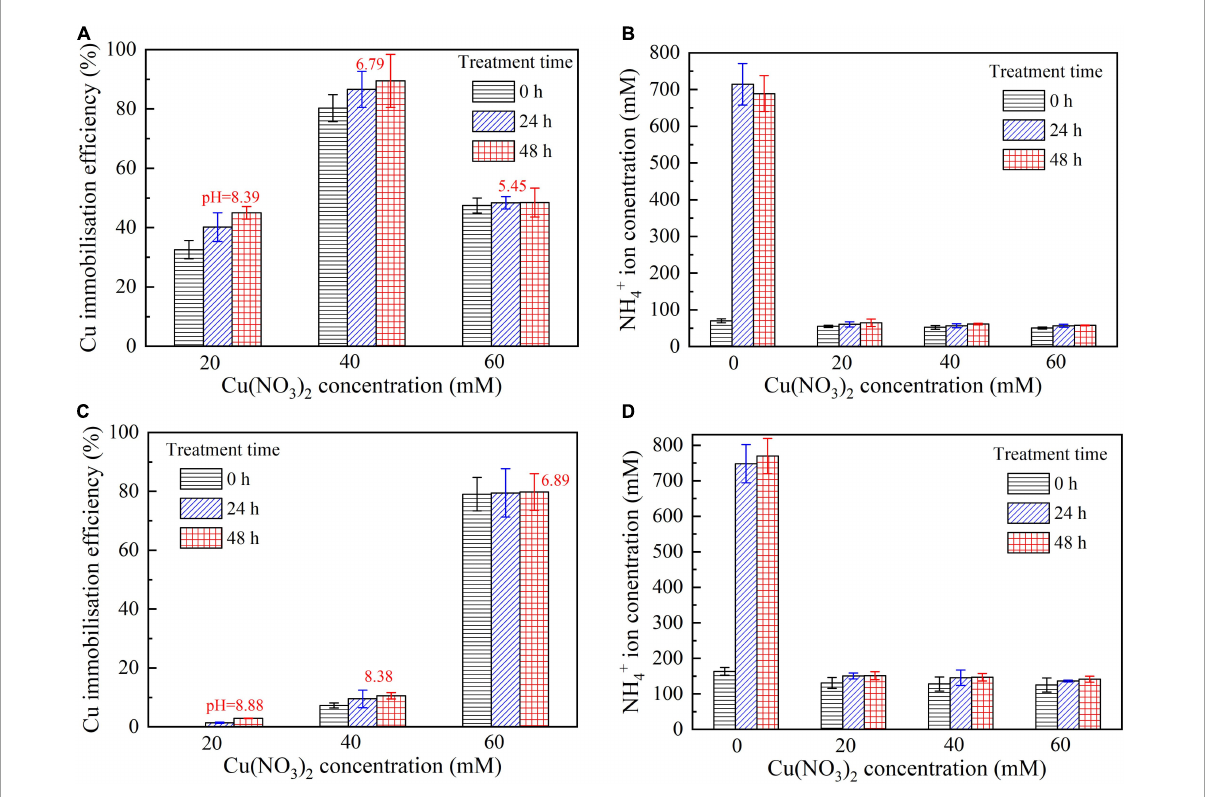
FIGURE9 (A) copper immobilization efficiency vs. Cu(NO 3 ) 2 concentration relationship and (B) NH 4 + concentration vs. Cu(NO 3 ) 2 concentration relationship for the inoculation proportion = 1:9; (C) copper immobilization efficiency vs. Cu(NO 3 ) 2 concentration relationship and (D) NH4 + concentration vs. Cu(NO 3 ) 2 concentration relationship for the inoculation proportion =